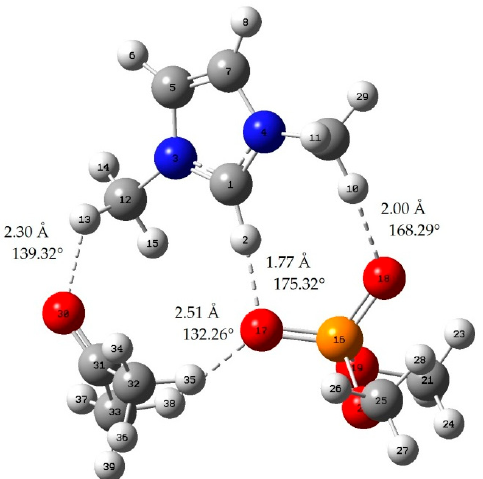
Figure A6. Acetone-[MMIM][DMP]; red: oxygen atom; green: chlorine atom gray: carbon atom; white: hydrogen atom; blue: nitrogen atom; dotted line: hydrogen bond.